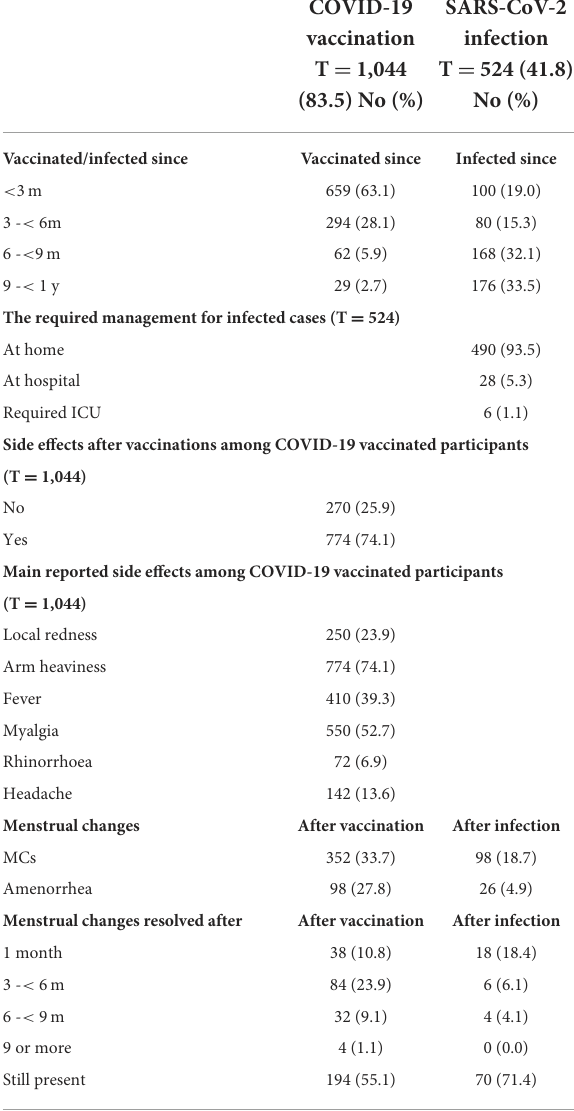
TABLE 4 COVID-19 vaccination, and related menstrual changes among the studied